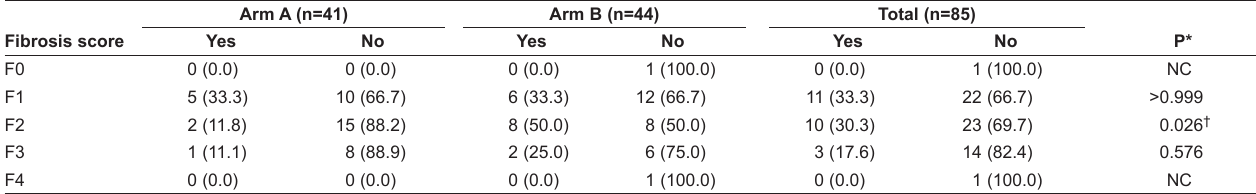
Table 2 Rapid virological response according to fibrosis score – intent to treat Fibrosis score